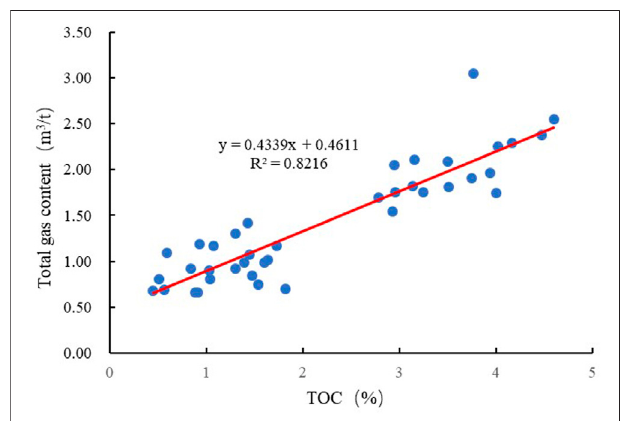
FIGURE7 | Relationshipbetween theTOC and the total gascontentsof the Longmaxi Formation shale in the Changning area.